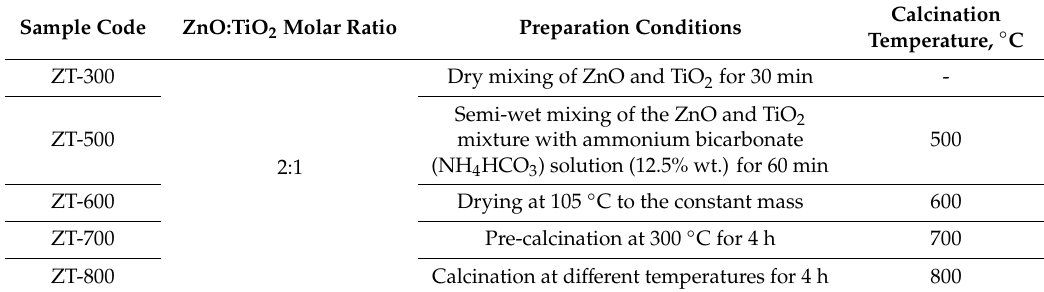
Table 1. Composites synthesis